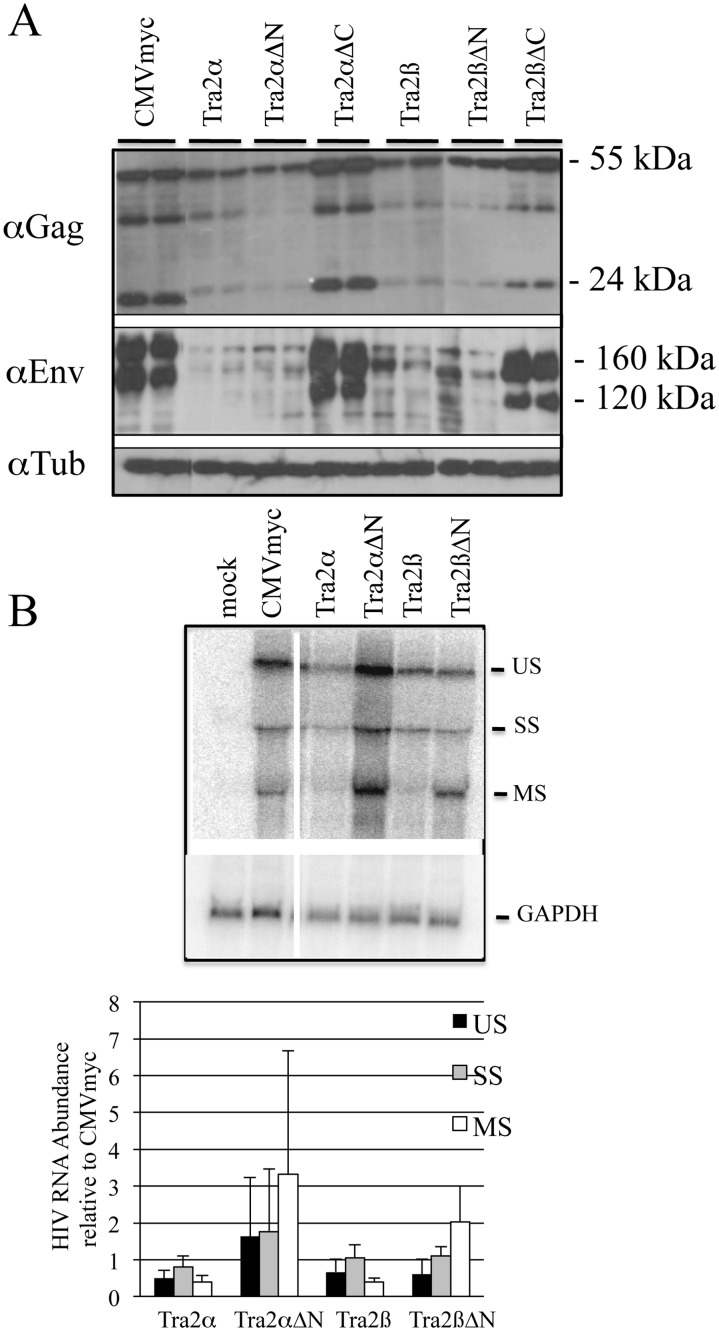
Tra2α/β Overexpression Alters HIV-1 Expression and RNA Accumulation.293T cells were transfected with pHxb2 R-/RI- and the indicated myc expression plasmids. 48 h post-transfection, cells were harvested for either analysis of (A) HIV-1 Gag and Env expression (loading of blots was confirmed with anti-tubulin antibody) or (B) viral RNA by northern blot. Probes used were specific for HIV-1 or GAPDH RNA. On top is a representative sample of the northern blot results and at bottom, a summary of results of 3 independent assays. Values shown are normalized to the abundance of the respective HIV-1 RNA upon co-transfection with CMVmyc after adjusting for variation in loading using GAPDH RNA.